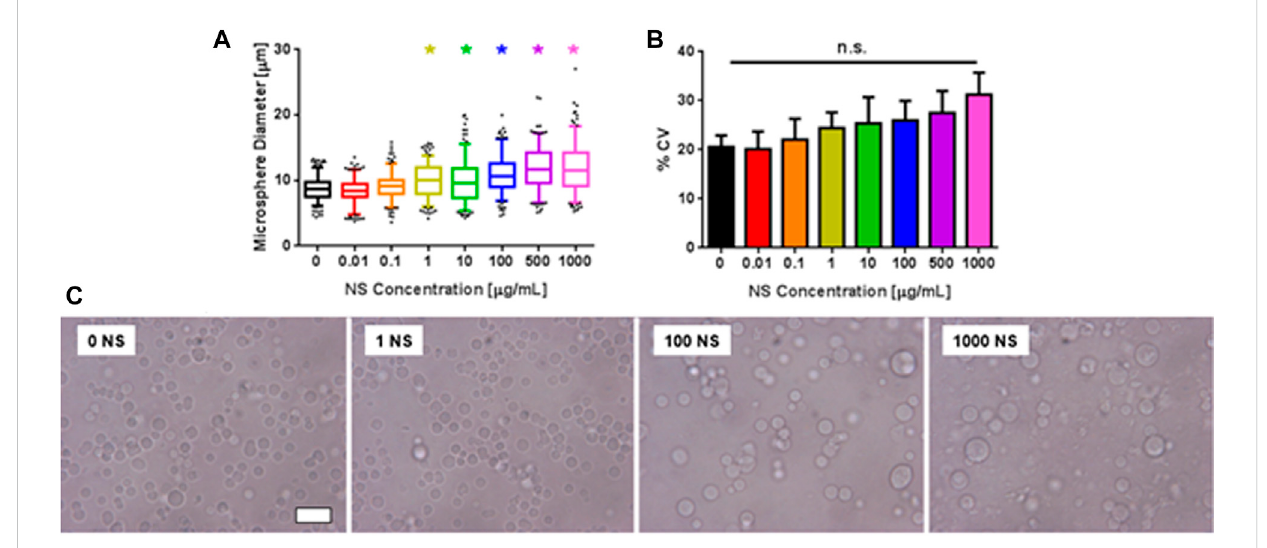
FIGURE 4 Effect of NS concentration on PEG microsphere size. (A) Microsphere diameter as a function of NS concentration. * indicates statistically signi fi cant difference from 0 μ g/mL NS group ( n = 3, p < 0.5). (B) % CV of microsphere diameter as a function of NS concentration. (C) Phase contrast microscope images of microspheres at various NS concentrations. Scale bar represents 20 μ